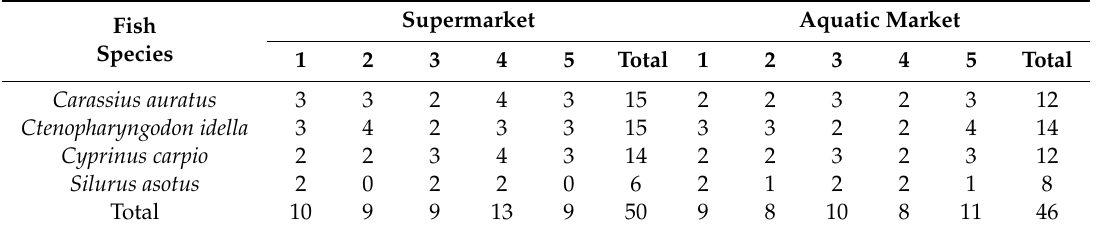
Table 1. Species, quantity, and origin of fish sampled in spring. Fish